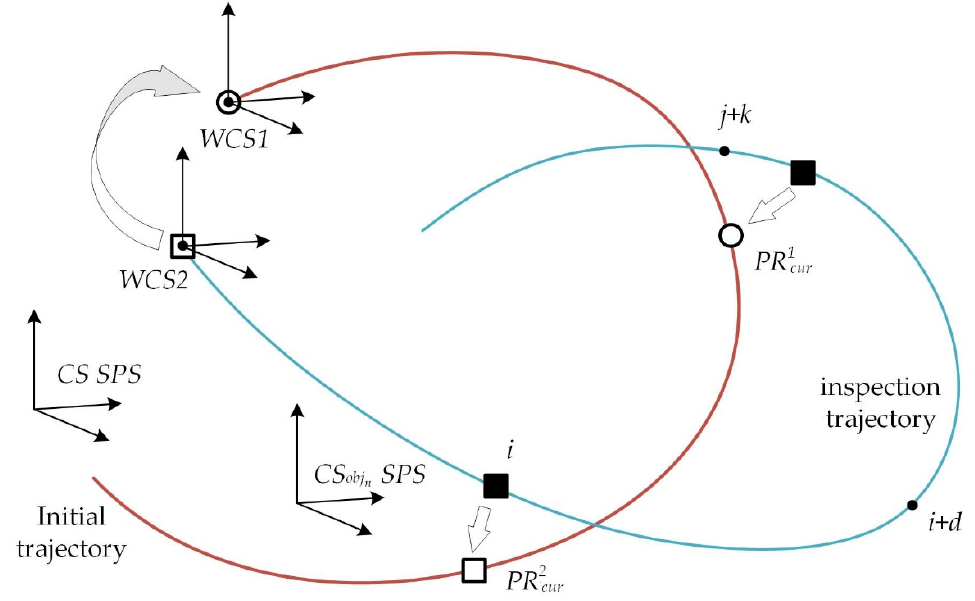
Figure 6. Calculation of inspection trajectory using virtual points of VCRN (starting points S1 and S2 are